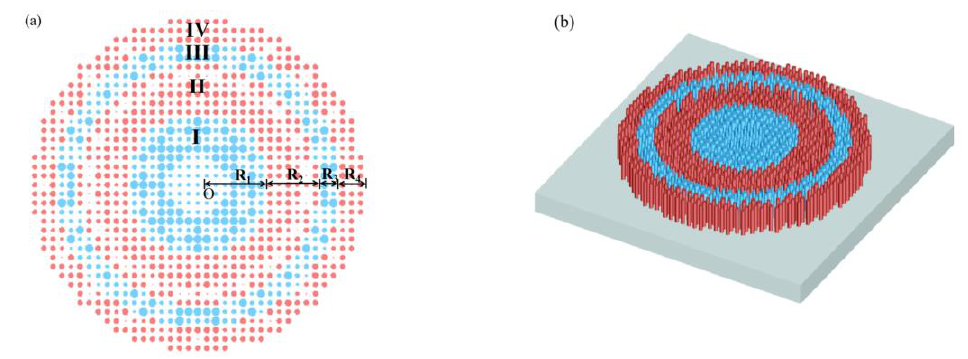
Figure 3. ( a ) Schematic diagram of the dual-wavelength achromatic metalens; ( b ) top view of the designed metalens. designed